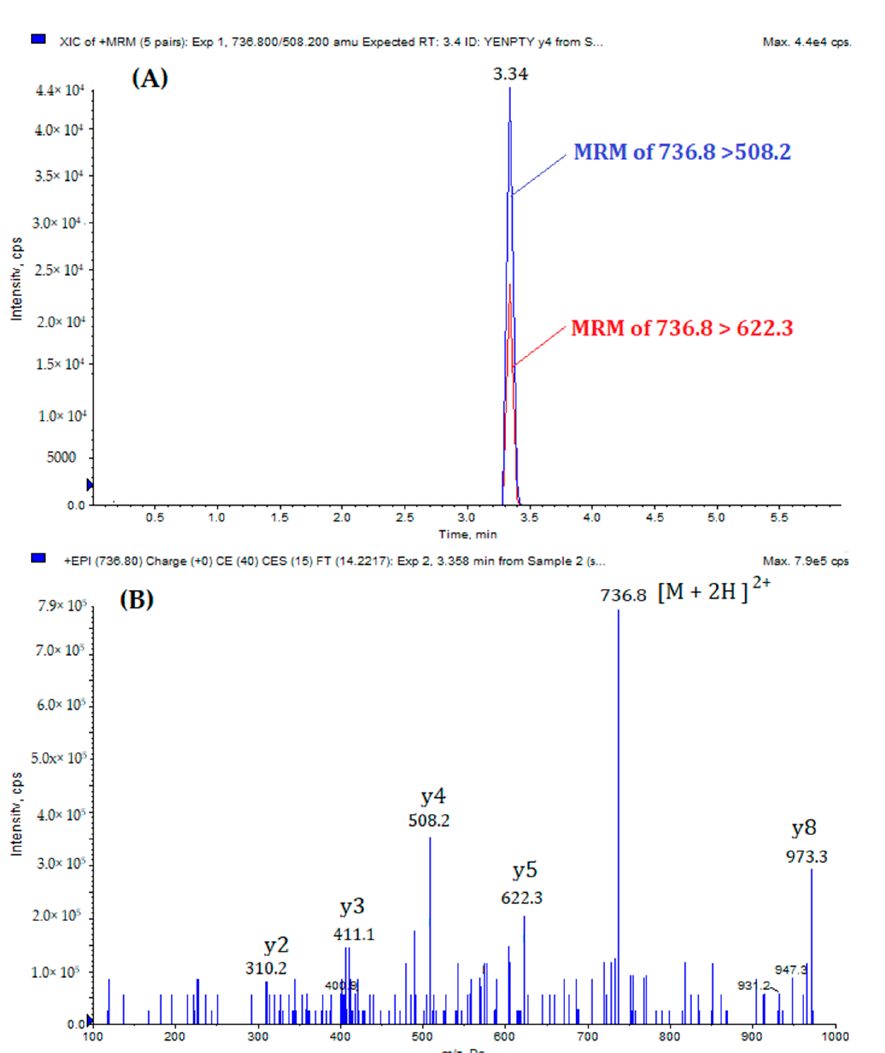
Figure 1. ( A ) Extract ion chromatogram of MQQNGYENPTYK: MRM transition 736.8 > 508.2 (blue) and 736.8 > 622.3 (red). ( B ) EPI spectrum of MQQNGYENPTYK. The validation was obtained by analyzing calibration curves and quality controls. The linearity of calibration curves for both peptides, MQQNGYENPTYK and MQQNGYpENPTYK, was estimated by the coefficients of correlation (r) which were respectively 0.9972 and 0.9984. The slopes were 0.30970 and 1.05976 and intercept values were − 0.00604 to − 0.00309 (Table